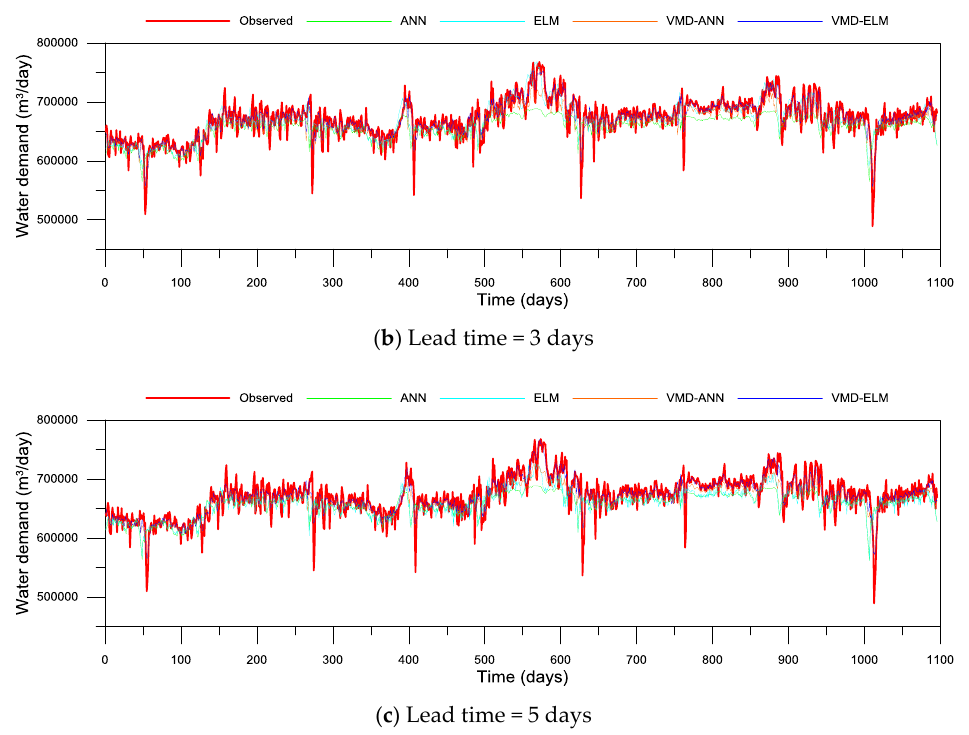
Figure 11. Time series plots for single and VMD-based forecasting models.